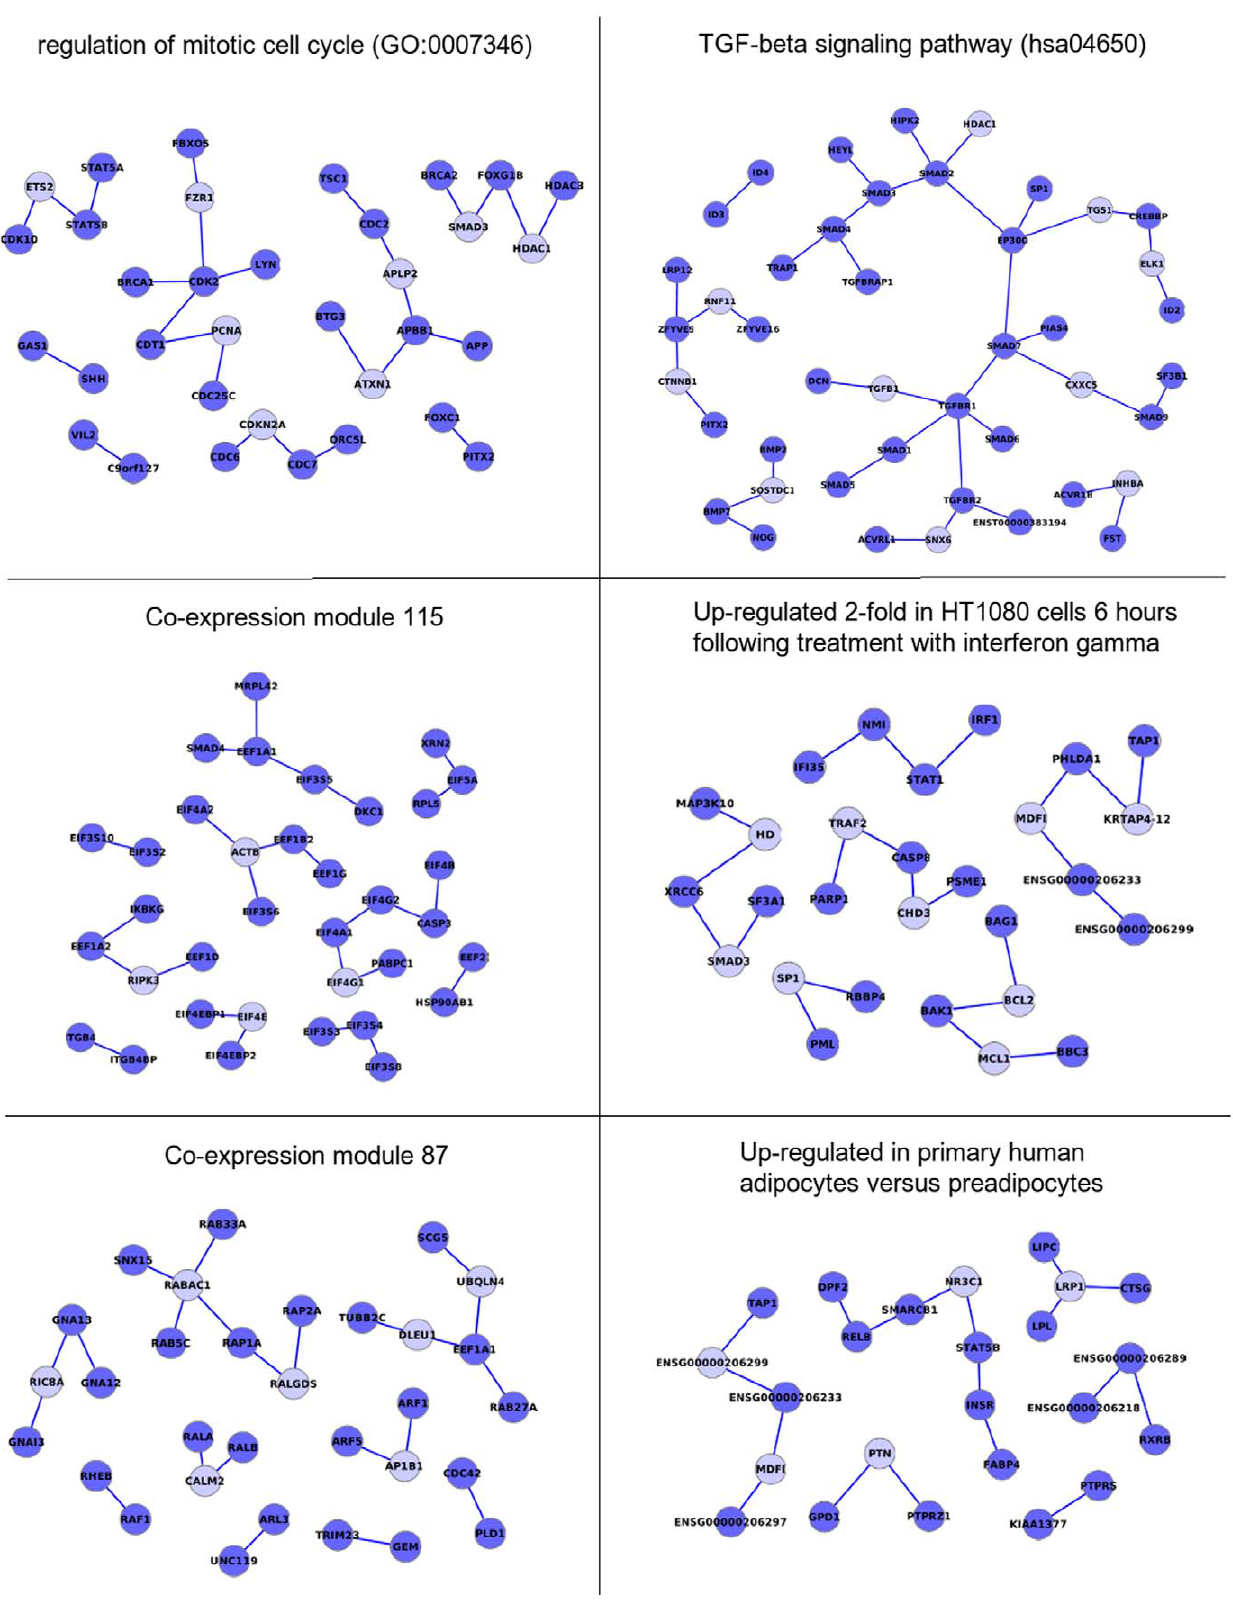
Figure 3. Examples of networks with significant parameters obtained for different module definitions. The networks have been obtained for different types of modules (GO, KEGG, signatures and co-expression modules). All the networks have been chosen with a similar number of nodes (around50genes/proteins).Inthe networks represented, additionalnodes connectingnodes inthe listswere allowed. Table 5showsthesignificance of the network parameters obtained for the modules. Nodes originally in the list are represented in dark blue and extended nodes in pale blue. doi:10.1371/journal.pone.0017474.g003 PLoS ONE |